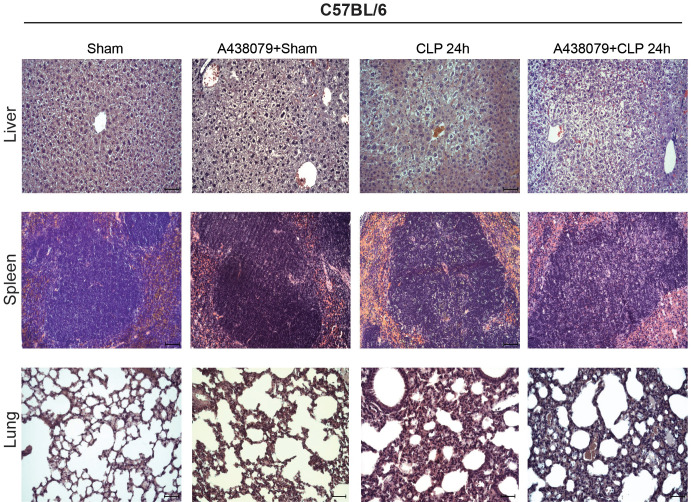
Impact of P2X7 antagonist A438079 in sepsis.Representative images of hematoxylin and eosin-stained liver, spleen, and lung sections obtained 24 hr after CLP from C57BL/6 (wild-type) mice treated with A438079 (100 µM/kg) 1 hr before CLP. Scale bar 50 μm; images representative of n = 6 independent mice.